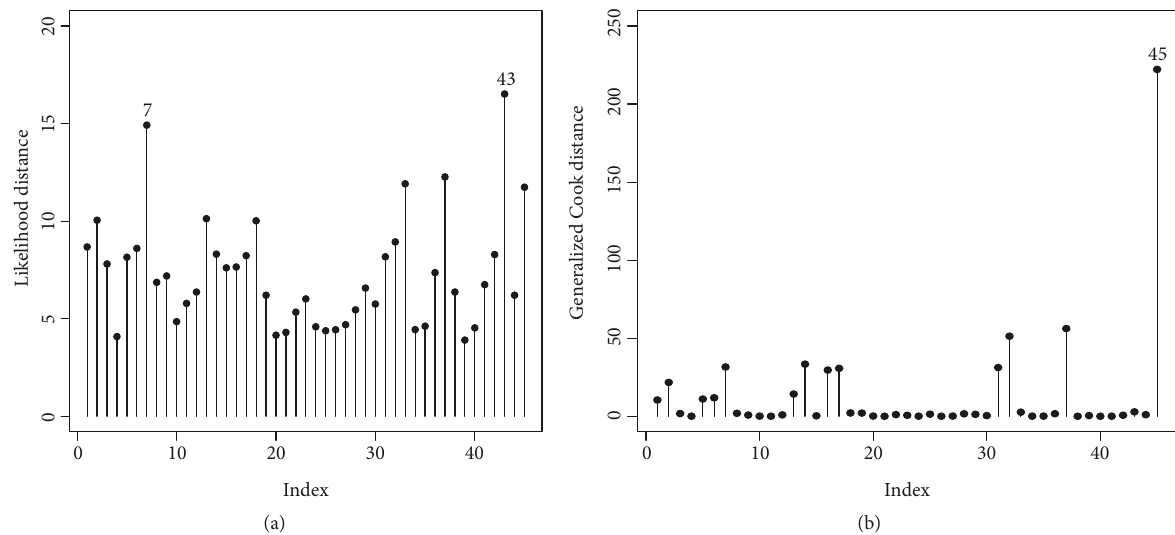
Figure 8: Index plot for 𝜃 : (a) 𝐿𝐷 𝑖 ( 𝜃 ) (likelihood distance) and (b) 𝐺𝐷 𝑖 ( 𝜃 ) (generalized Cook’s